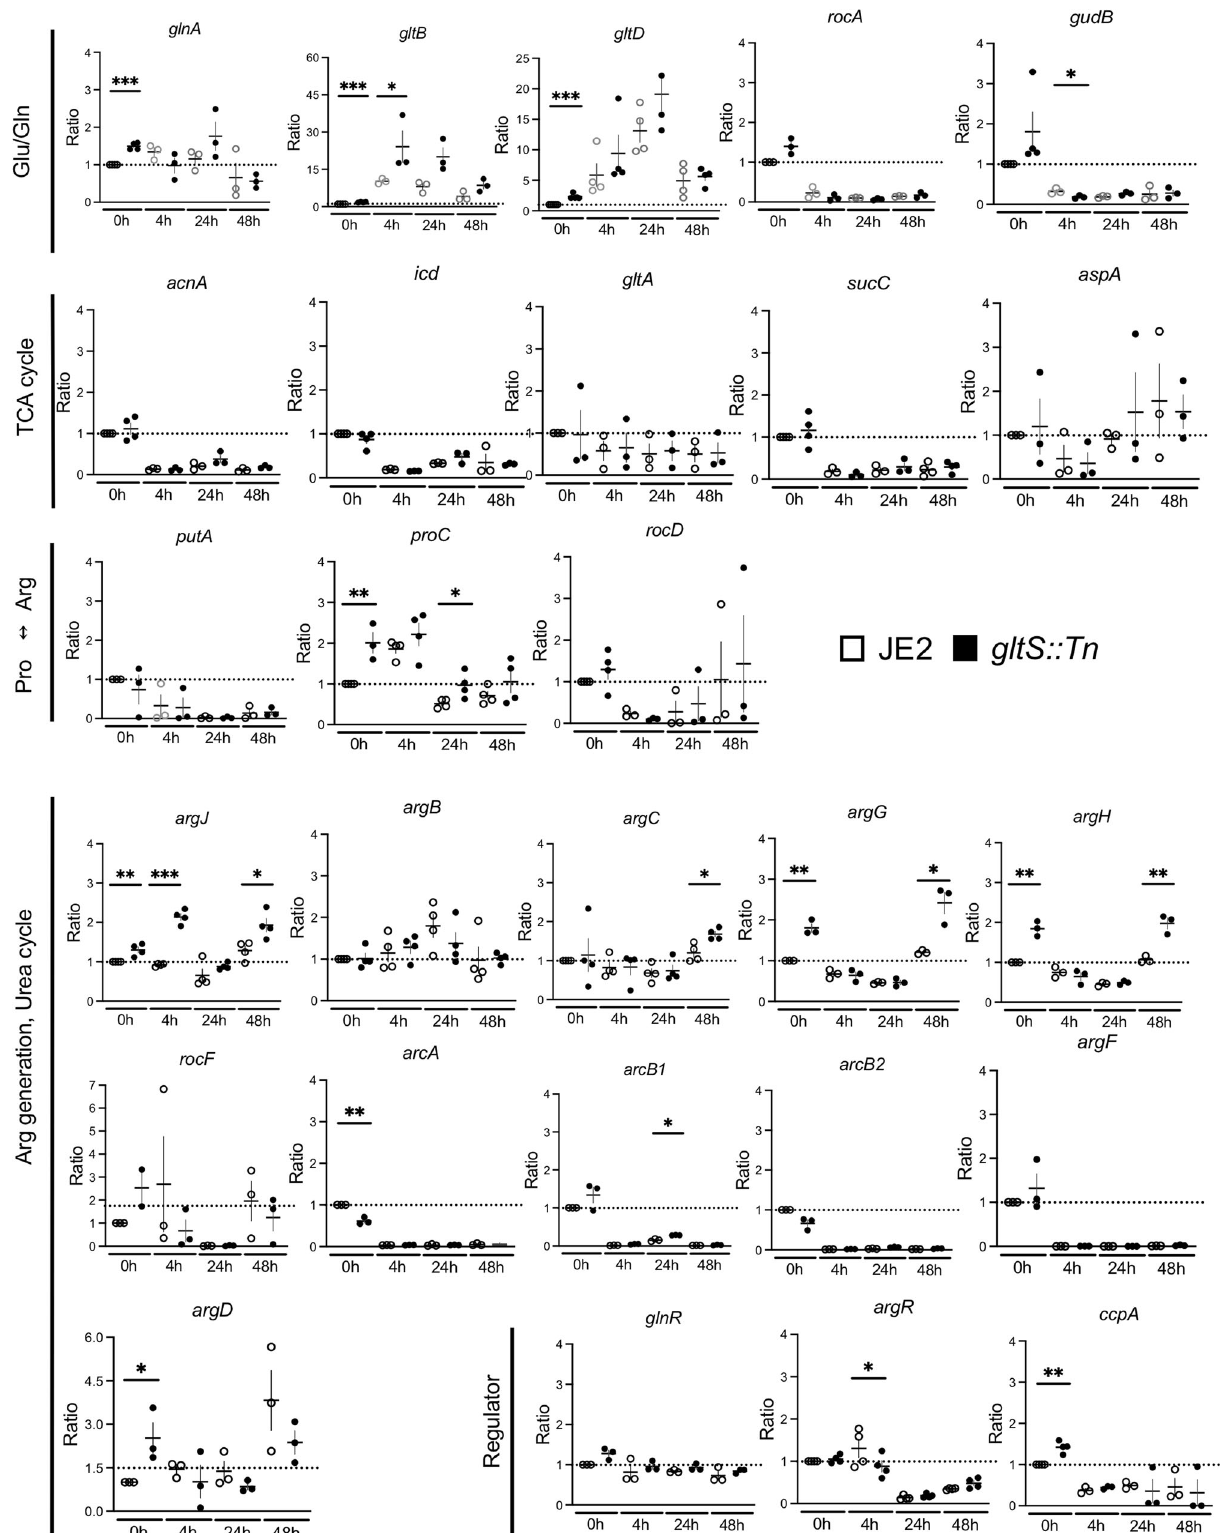
Fig. 5 Relative expression of genes related to metabolism and bio fi lm formation in S. aureus as determined by RT-PCR. Expression ratio based on the 0-h value of the JE2 strain over three independent tests. 0 h corresponds to planktonic cells, while 4 h, 24 h and 48 h correspond to bio fi lm cells at 4, 24, and 48 h-incubation, respectively. Data are mean ± SD of 3 – 4 replicates. Student t-test between strains of samples collected at the same time. * P < 0.05, ** P < 0.01, *** P <